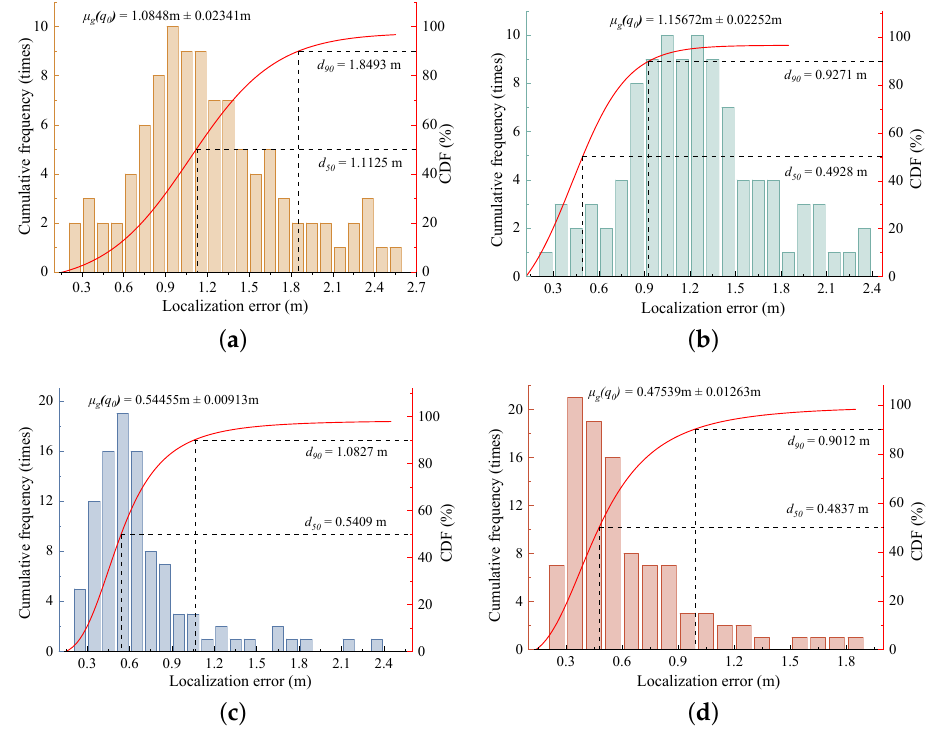
Figure 17. Cumulative probability distribution. ( a ) PSO. ( b ) GWO. ( c ) EWCL. ( d ) ILP-PSOGWO. Figure 17 depicts the cumulative frequency distribution and cumulative frequency distribution of 100 localization errors obtained by the four methods. The average local- ization errors obtained by PSO, GWO, EWCL and ILP-PSOGWO are 1.0848 m, 1.15672 m, 0.54455 m and 0.47539 m, respectively. Figure 17 also shows that the localization errors ob- tained by PSO and GWO are mostly distributed between 0.6m and 1.8 m, and the frequency of occurrence is fewer than 10 times, indicating that the stability of these two methods is poor. In contrast, the localization errors of EWCL and ILP-PSOGWO are mostly distributed between 0.3 m and 0.7 m, and the frequency of occurrence is as high as 20, indicating good stability. Figure 17d indicates that 90% of the localization errors of ILP-PSOGWO are less than 0.9012 m, and 50% are less than 0.4837 m, which is better than the other three